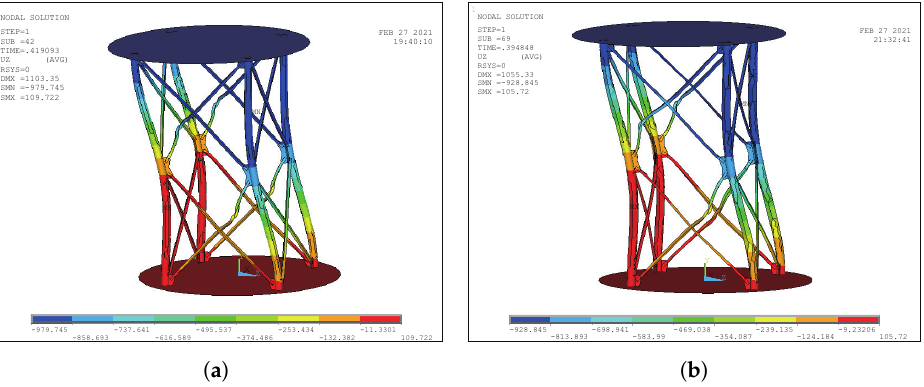
Figure 14. ( a ) The maximum displacement in horizontal Z direction of quadrilateral tower with the SLSPJ. ( b ) The maximum displacement in horizontal Z direction of quadrilateral tower with the